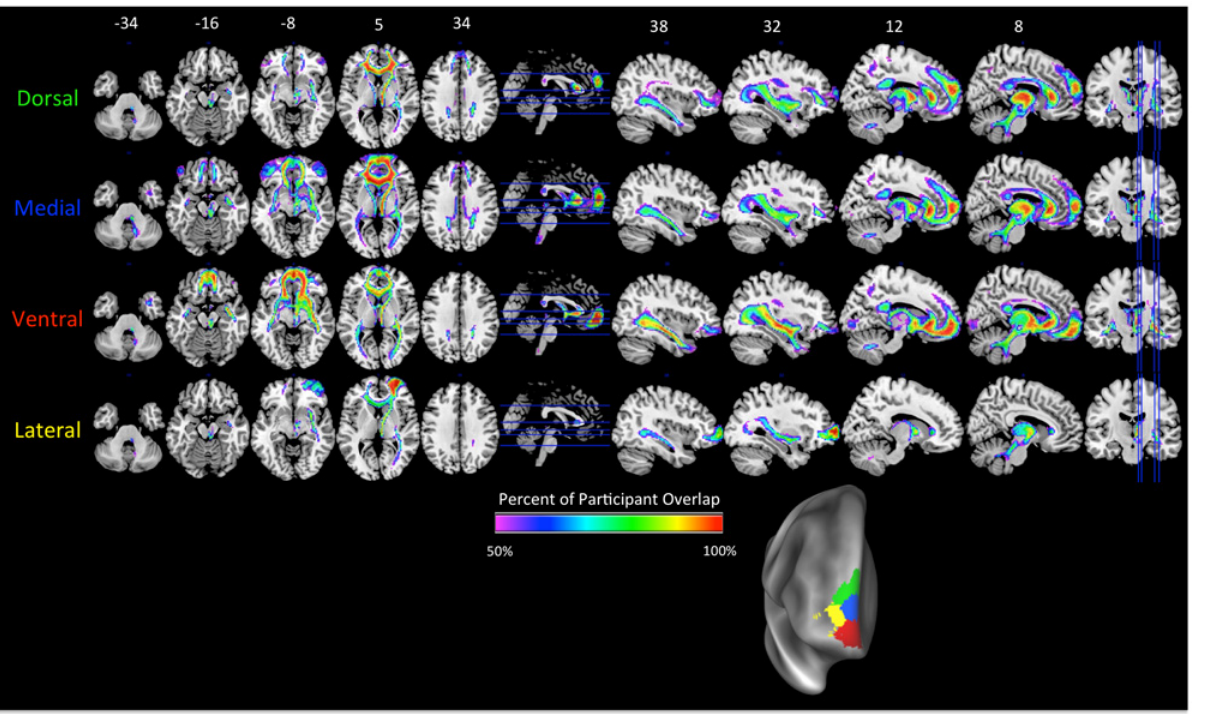
Fig 4. Tracts originating from each of the clusters in the right hemisphere K = 4. Label colors (on left) match the cluster colors in Fig 2 (K = 4), which is reproduced at the bottom right. The color scale on brain maps represents the proportion of tract overlap across the participants, with the maps thresholded at 50%. Axial slices are shown in the left column, with slice locations marked on the sagittal slice with a blue line. Sagittal slices are shown in the right column, with slice locations marked on the axial slice with a blue line. MNI coordinates for the z -axis (axial slices) and x -axis (sagittal slices) are shown above the top